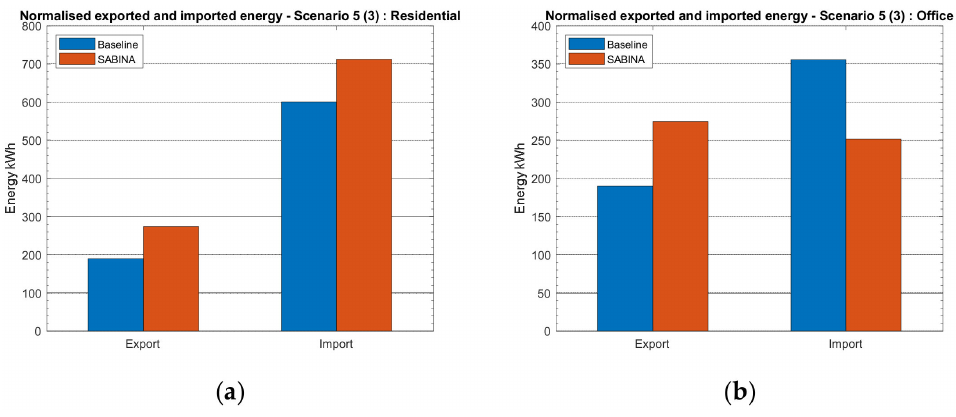
Figure 9. Normalised energy grid exchange: ( a ) residential (3); ( b ) office (3).